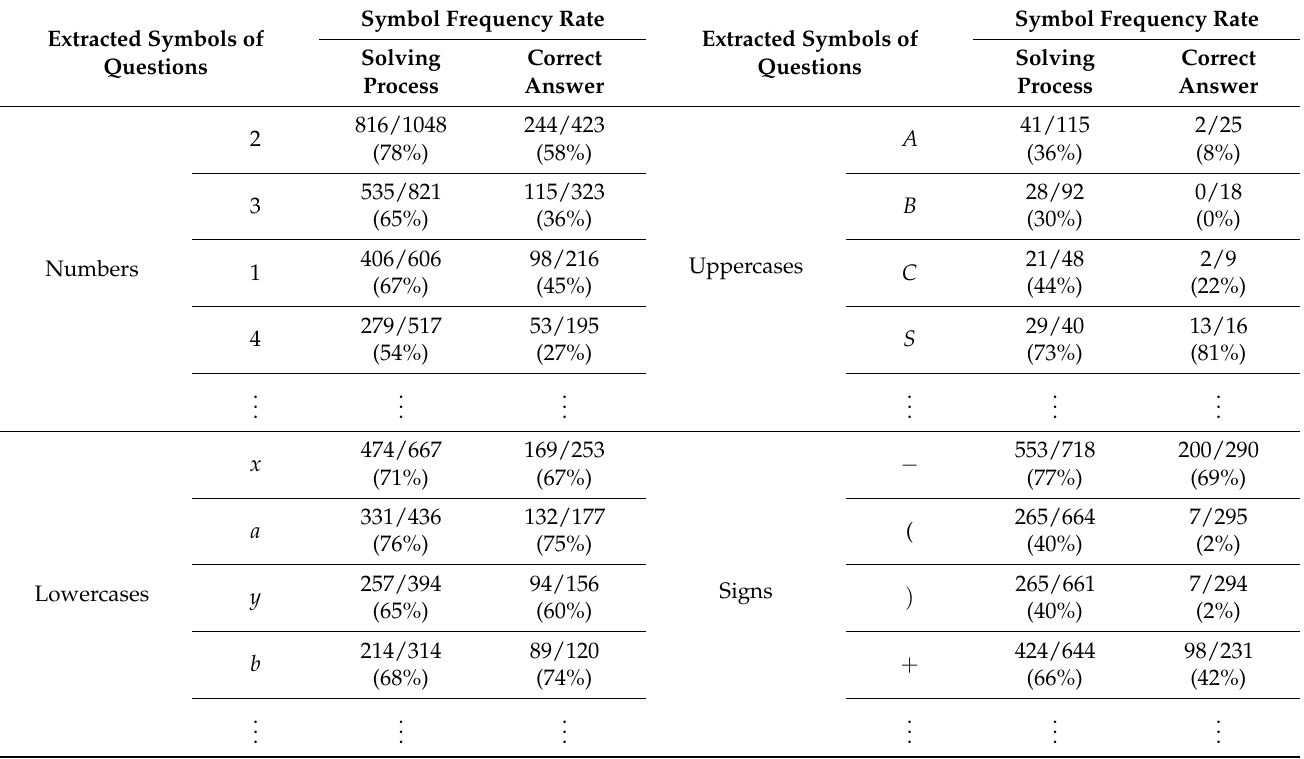
Table A4. Sample Symbol Frequency Rates in Solving Processes and Correct Answers for Symbols Extracted from Questions.